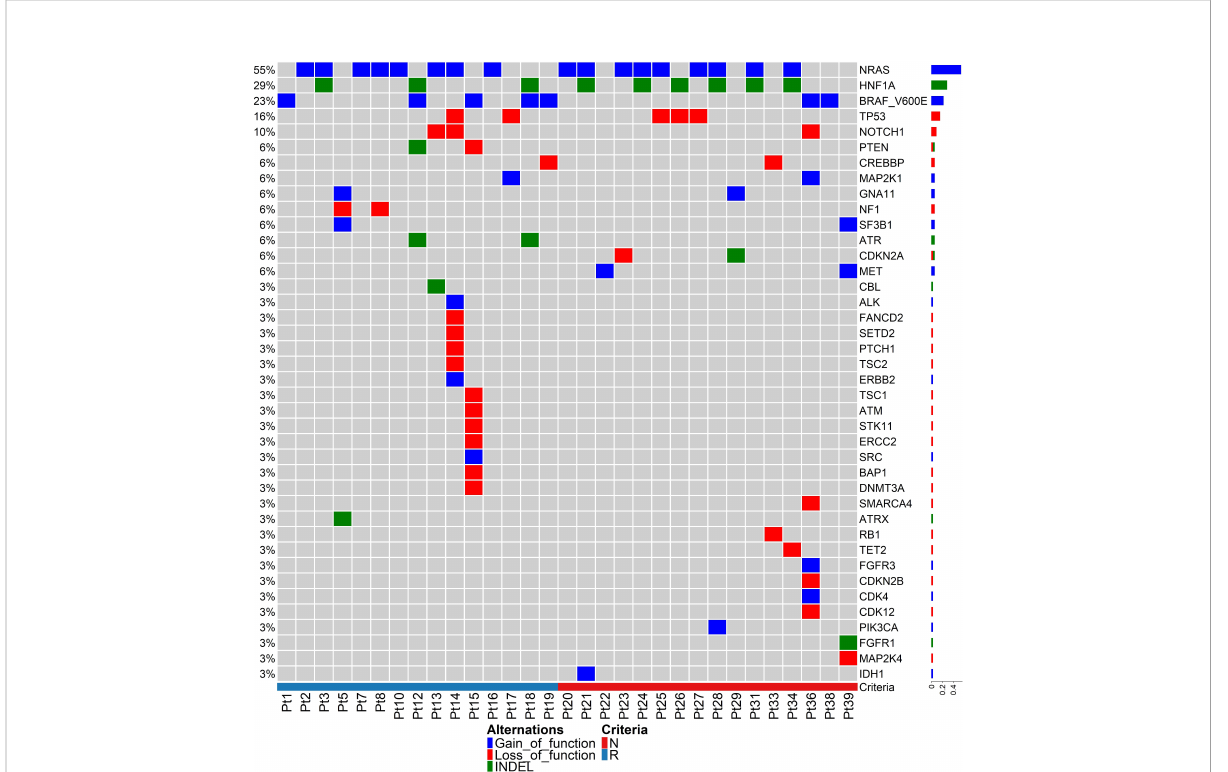
FIGURE 1 Tumour mutation analysis between responding and non-responding melanomas. Driver mutations in pre-treatment melanomas of responding versus non-responding patients prior to anti-PD-1 therapy. The heatmap represents only 31 samples because these samples passed an in-built QC (quality control) test with ≥ 80% depth of read uniformity in sequencing using the Oncomine Tumour Mutation Load – w3.0 – DNA – Single Sample in the Ion Reporter cloud